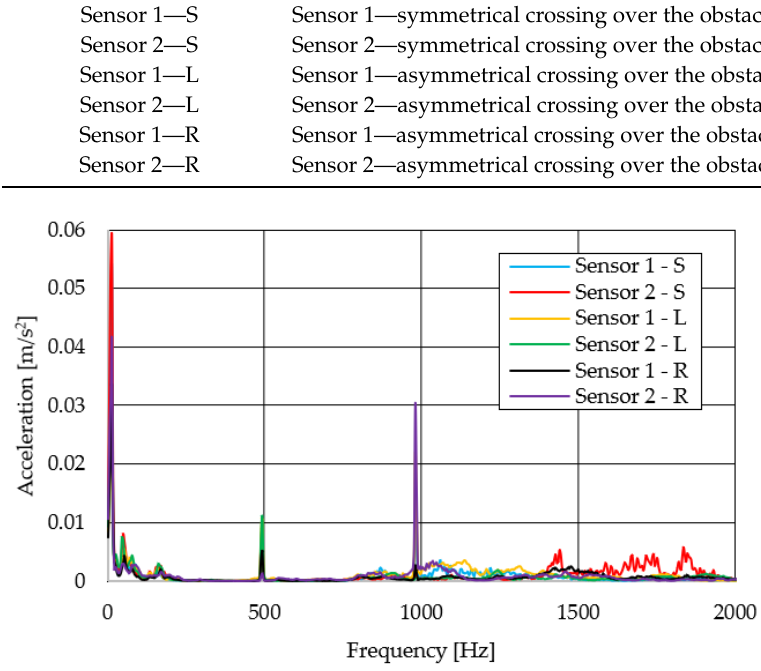
Figure 26. Comparison of the frequency waveforms in the x -axis.